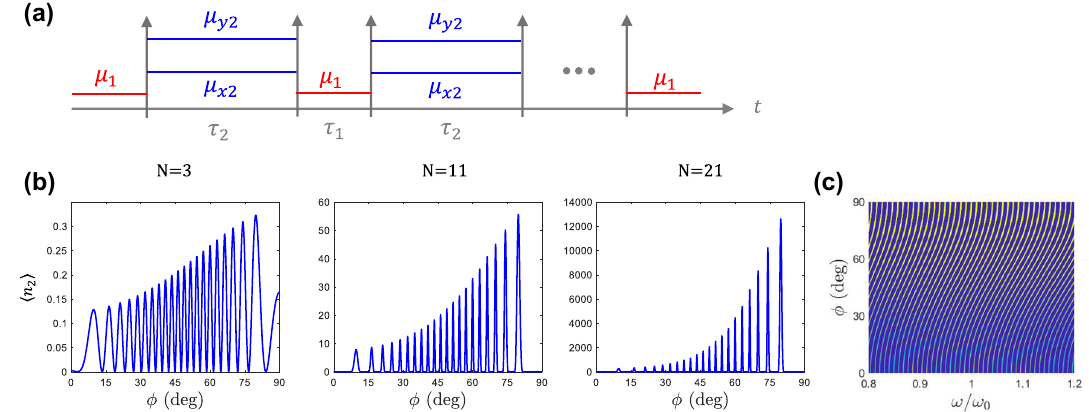
Figure 7: Generation of angular and frequency combs. Same as in Figure 6, except the duration of the second temporal slab has been = (100 𝜋 + 𝜋 ∕ 2) ∕ 𝜔 𝜙 = 60 deg. Plots in (b) show that photon yields an angular comb with multiple peaks of extended to 𝜏 k 0 2 , with 2 0 emission. Plot in (c) shows that the angular comb periodically shiftes with frequency, forming a frequency comb along a single